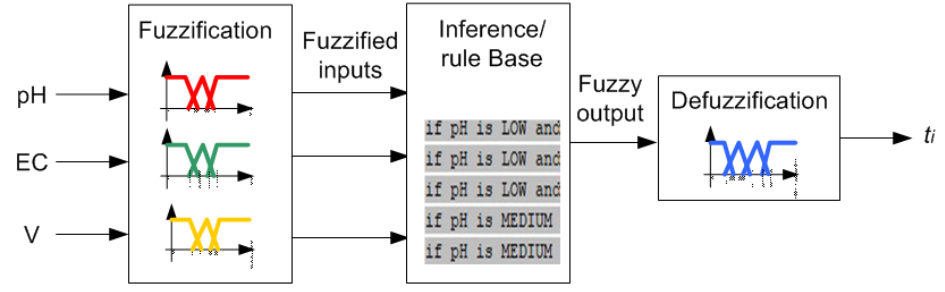
Figure 10. Fuzzy inference engine architecture.